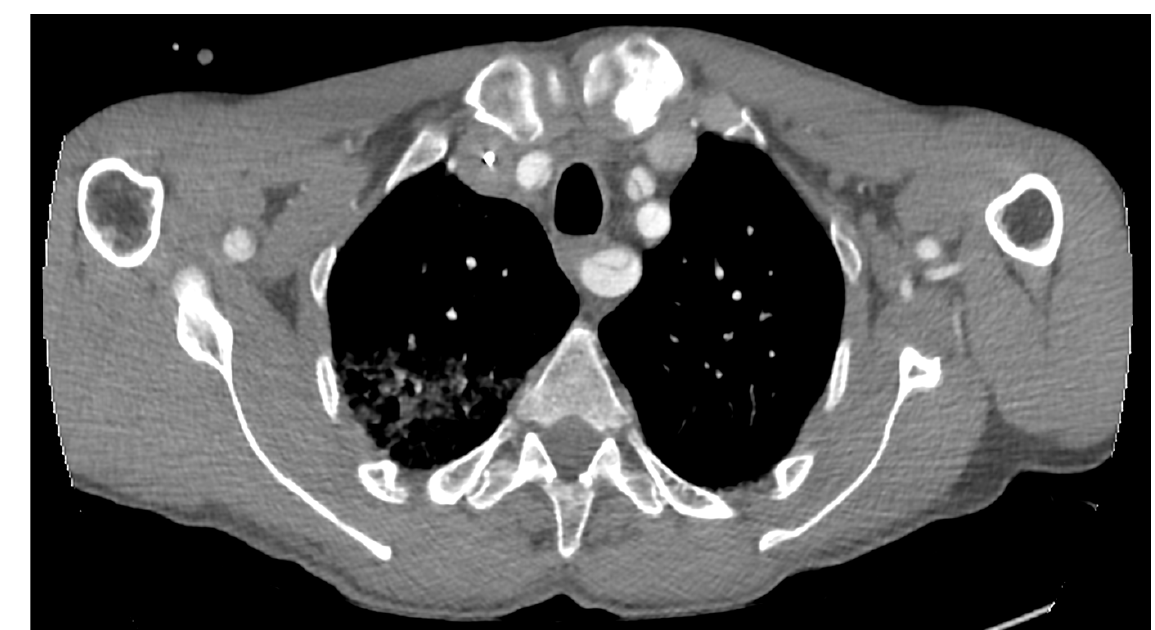
Medicina 2022 , 58 , x FOR PEER REVIEW Figure 4. Intimal flap present in all the supra-aortic vessels. Figure 4. Intimal flap present in all the supra-aortic vessels.